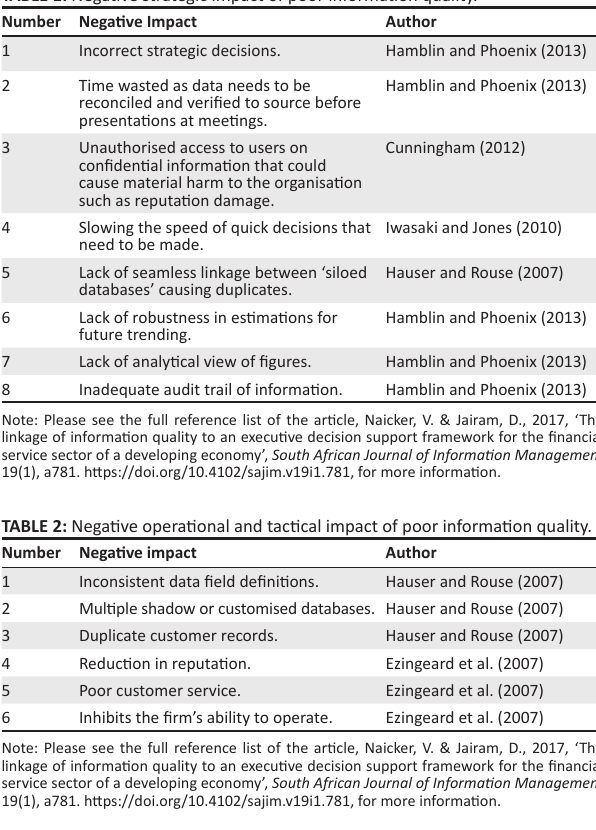
TABLE 1: Negative strategic impact of poor information quality.